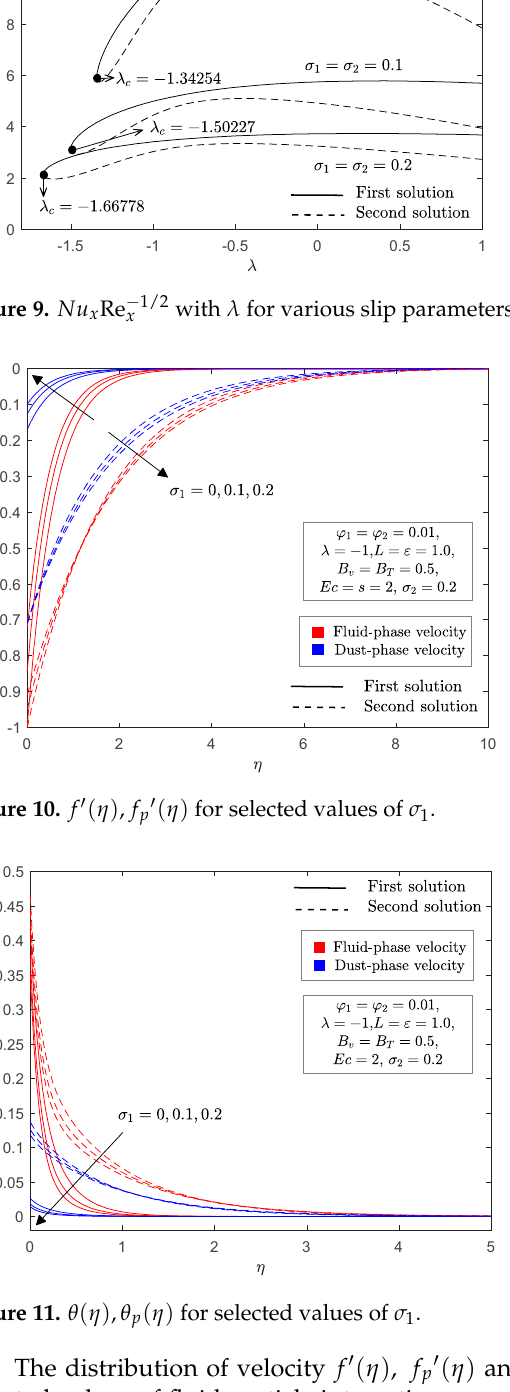
Figure 12. Figure 12.